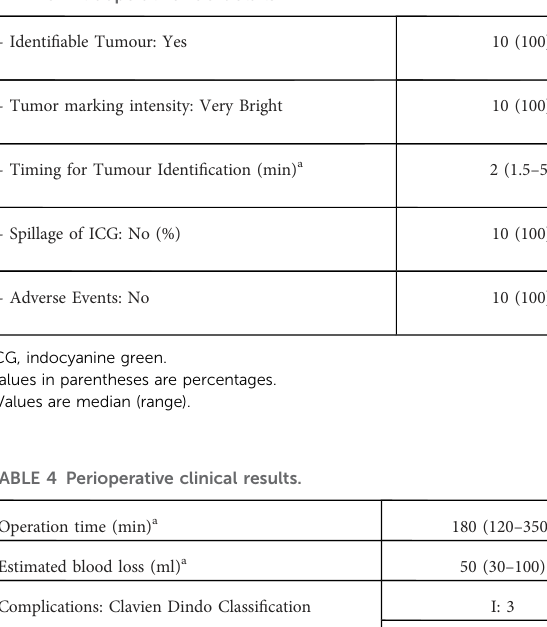
TABLE 3 Intraoperative ICG